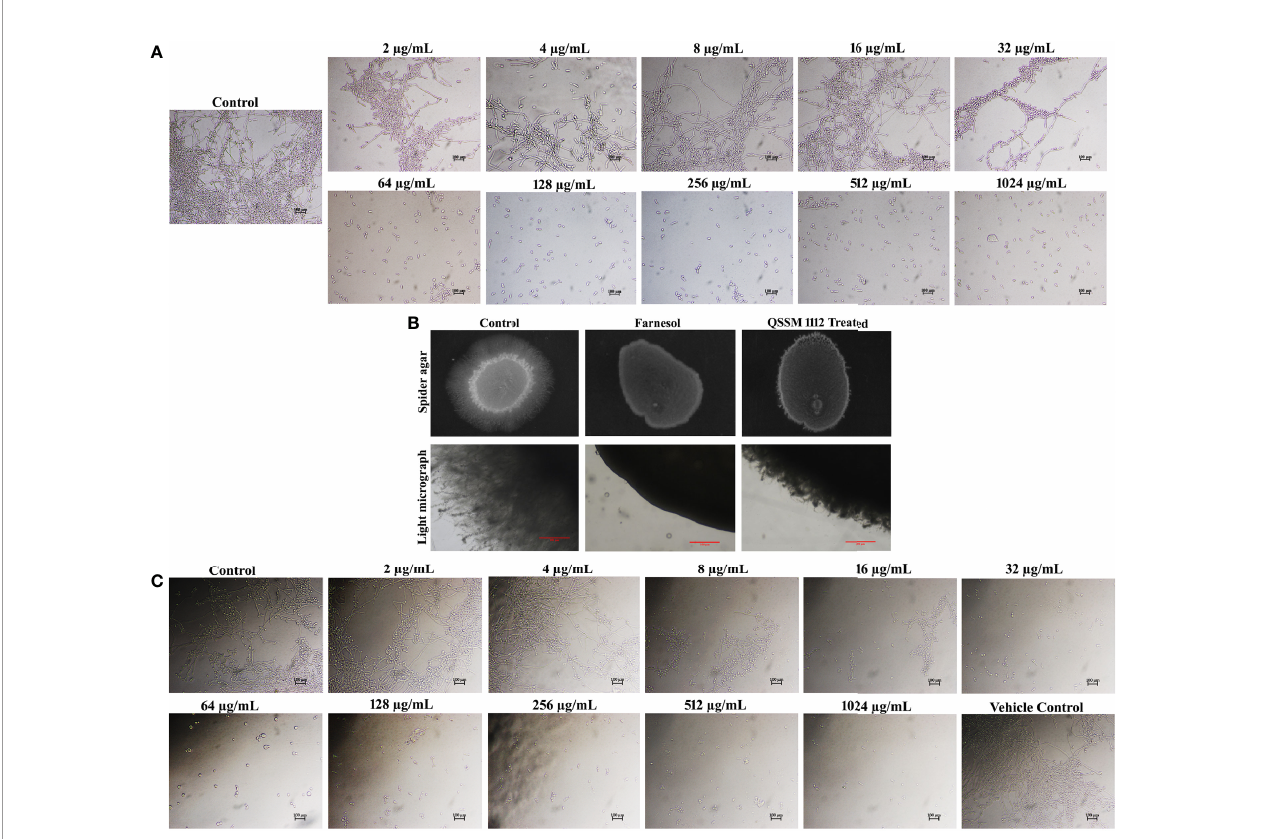
FIGURE 7 | (A) Inhibitory ef fi cacy of QSSM 1112 (0 – 1,024 µg/ml) on yeast-to-hyphal transition of Candida albicans in liquid spider media. After 24-h manifestation with QSSM 1112, C. albicans cells were photographed under a light microscope at ×400 magni fi cation. Micrograph of the control group portrays very dense and lengthy fi lamentous cells with few yeast cells; the QSSM 1112-treated groups display more number of evenly distributed yeast cells even from the lowest concentration (64 µg/ml). (B) Conformation of yeast-to-hyphal inhibition by QSSM 1112 using solid spider medium. The fungal colonies were imaged after 7 days of incubation at 37°C. The light micrograph and agar plate images clearly portray the remarkable reduction of hyphal protrusion in QSSM 1112-treated samples compared with untreated control (which bares deep and densely elongated hyphal network). (C) The impact of positive control farnesol (0 – 1,024 µg/ml) on C. albicans yeast-to-hyphal transition. The last panel in the fi gure showcases the effect of solvent (methanol) on yeast-to-hyphal